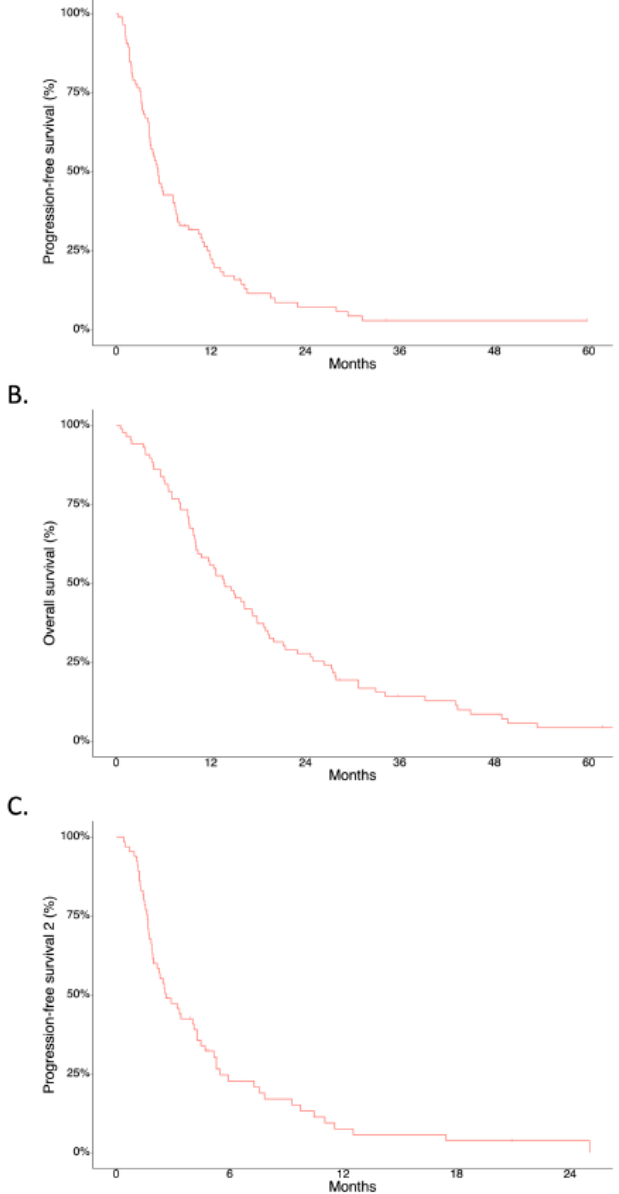
Figure 2. Survival outcomes of patients. ( A ) Progression-free survival after the first-line palliative chemotherapy (PFS1), ( B ) overall survival (OS), and ( C ) progression-free survival after the second-line palliative chemotherapy (PFS2).